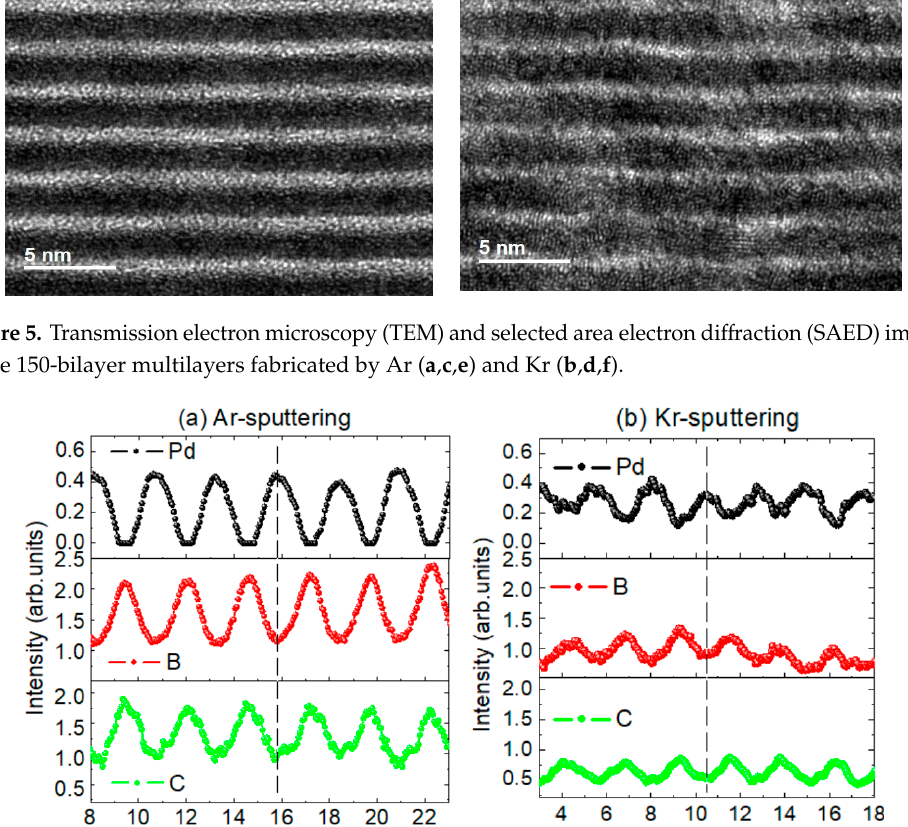
Figure 6. Electron energy loss spectroscopy (EELS) results of the depth profiles of the elemental concentration in Ar ( a ) and Kr ( b ) sputtered